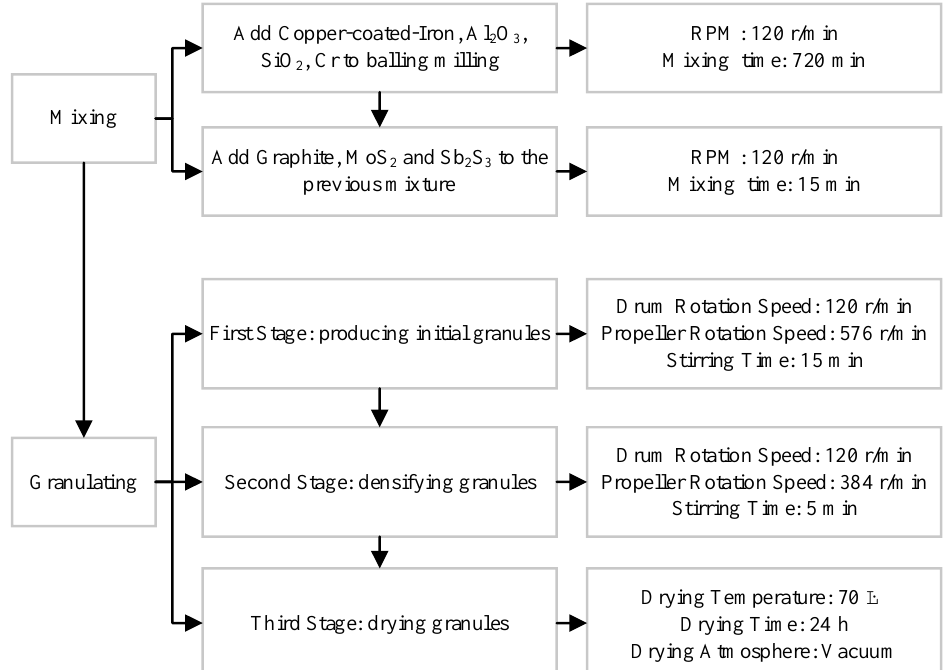
Figure 2. The mixing and granulating